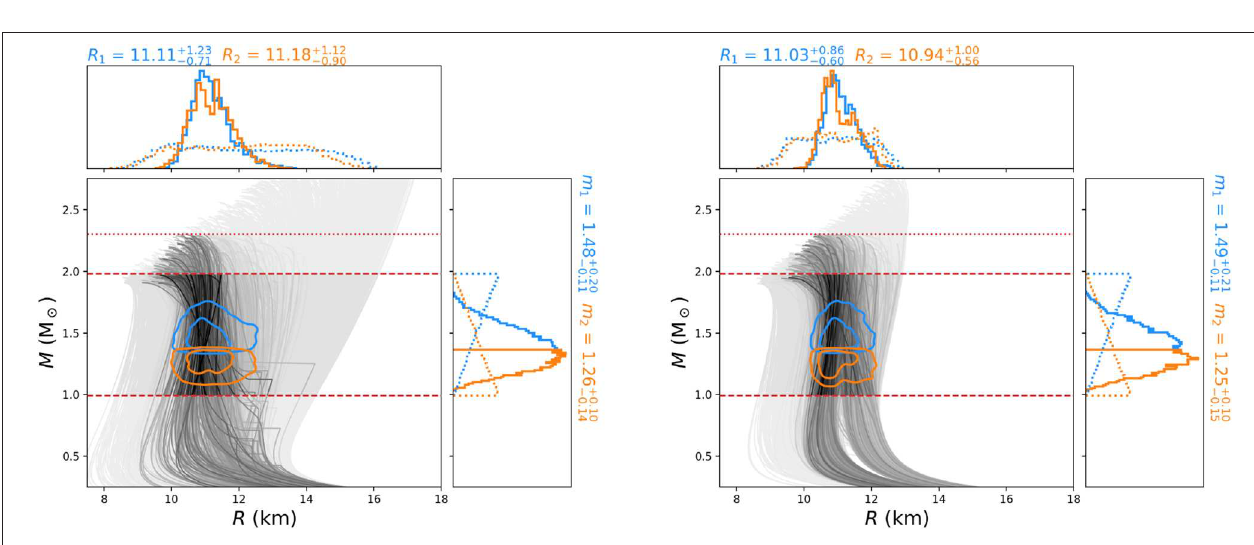
FIGURE 7 | Mass-radius posteriors after constraints from the binary neutron-star merger GW170817 are enforced for the EOS set with n tr (right) . The shading of the individual MR curves corresponds to their posterior probability. The red-dashed lines indicate the mass range spanned by the prior, and the red-dotted line indicates the maximum neutron-star mass constraint as inferred from GW170817. The colored contours indicate the 50th and 90th percent credibility regions for the two neutron stars in GW170817, with the corresponding 1D marginalized posteriors plots on the sides. Figure taken from Capano et al.